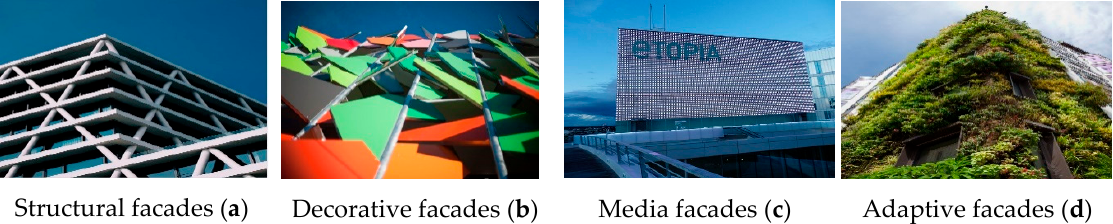
Figure 1. New trends for facades in modern architecture. Source: Public domain.